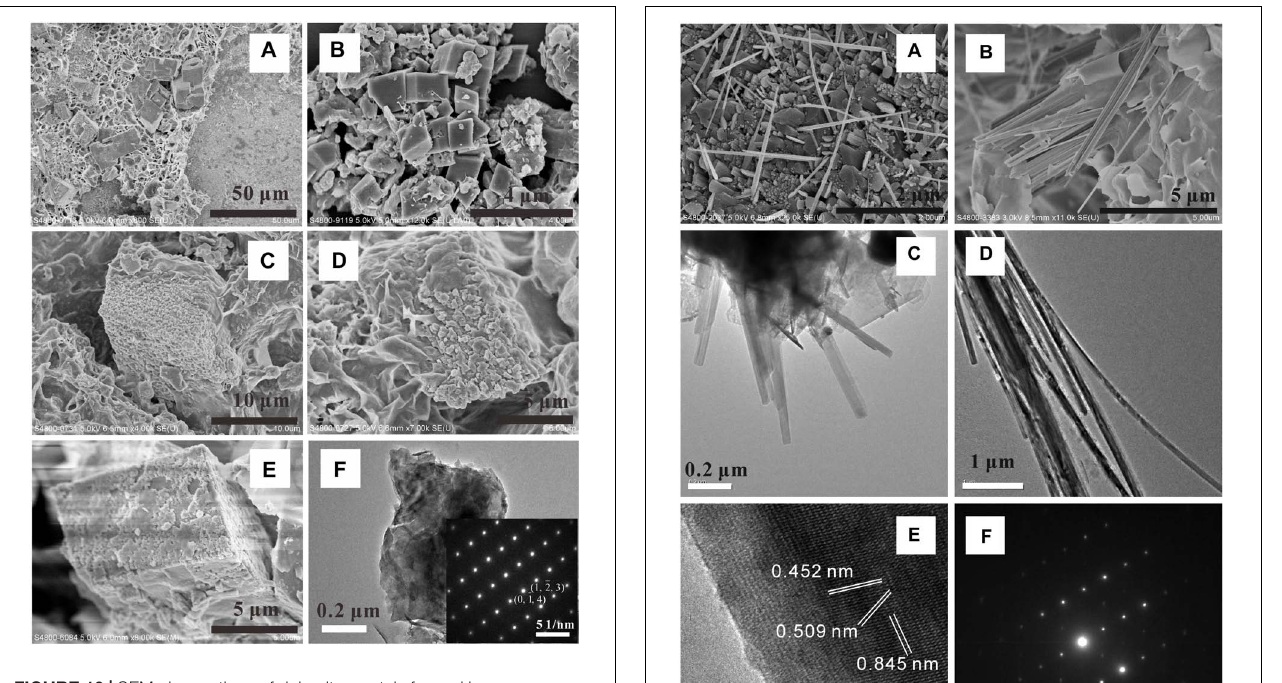
FIGURE 10 | SEM observations of dolomite crystals formed in [H 2 O-CO 2 ]-komatiite system (A,C) , [H 2 O-CO2]-basalt system (B) , and [H 2 O-CO 2 ]-peridotite system (D,E) . (F) TEM characterization of one dolomite crystal and the related SAED pattern.